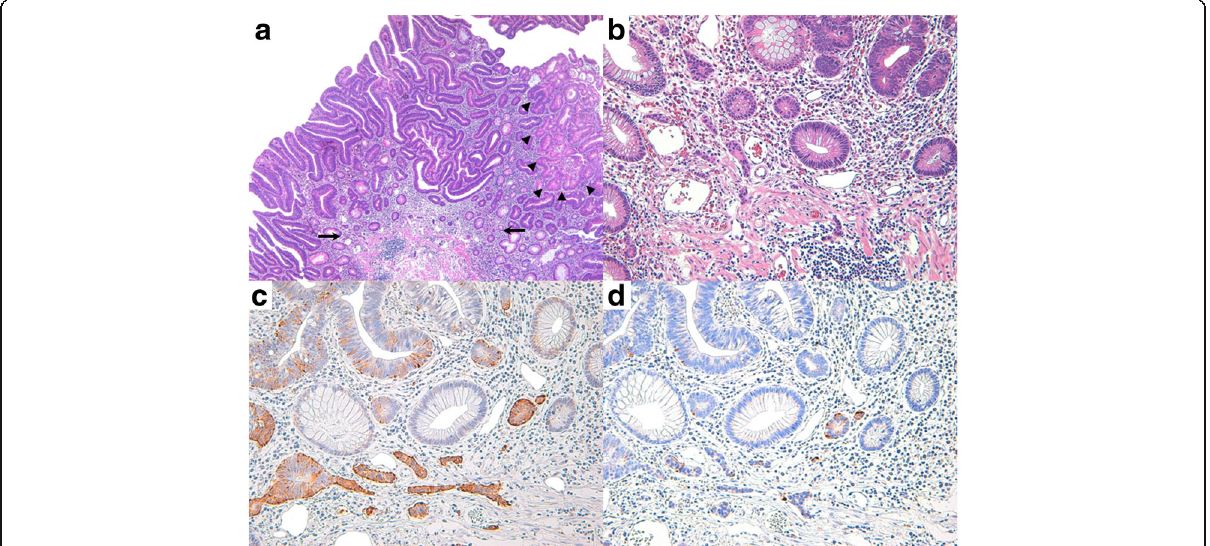
Fig. 2 Histological and immunohistochemical features of composite intestinal adenoma-microcarcinoid, mimicking invasive carcinoma. a Low power magnification shows adenomatous glands with minute microcarcinoid component (black arrows, ×40). Arrow heads indicate adjacent carcinomatous area. b High power magnification reveals endocrine cell nests with angulated shape and infiltrative growth pattern, harboring the potential for misdiagnosis as carcinoma invasion (×200). c Immunohistochemical staining for synaptophysin shows diffuse cytoplasmic reactivity